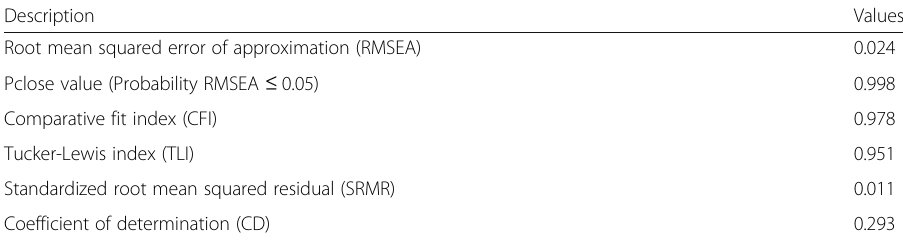
Table 7 Model fitness test of SEM results Description